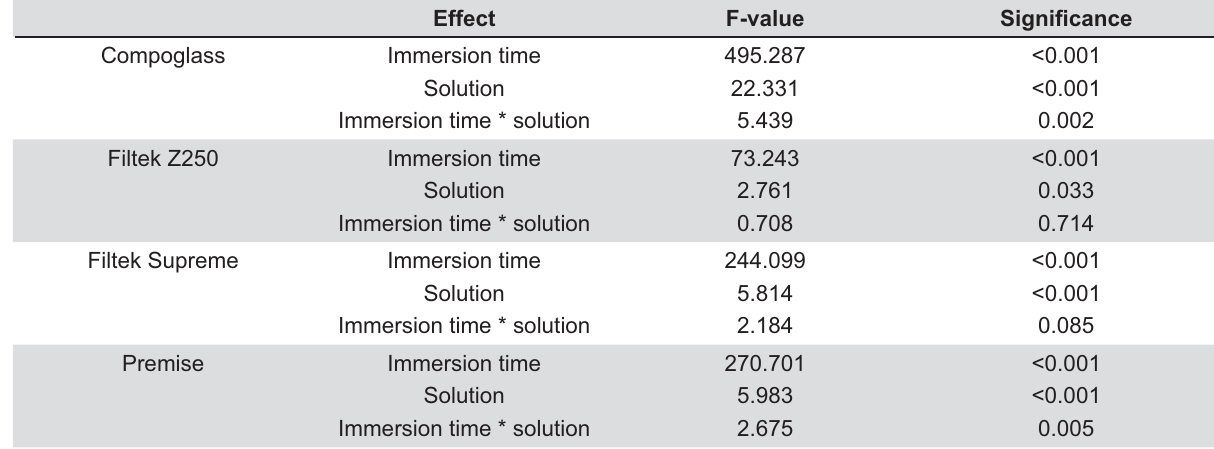
Table 2- Multivariate ANOVA results of the effects of interest (immersion time and solution) and interactions between these effects (immersion time *